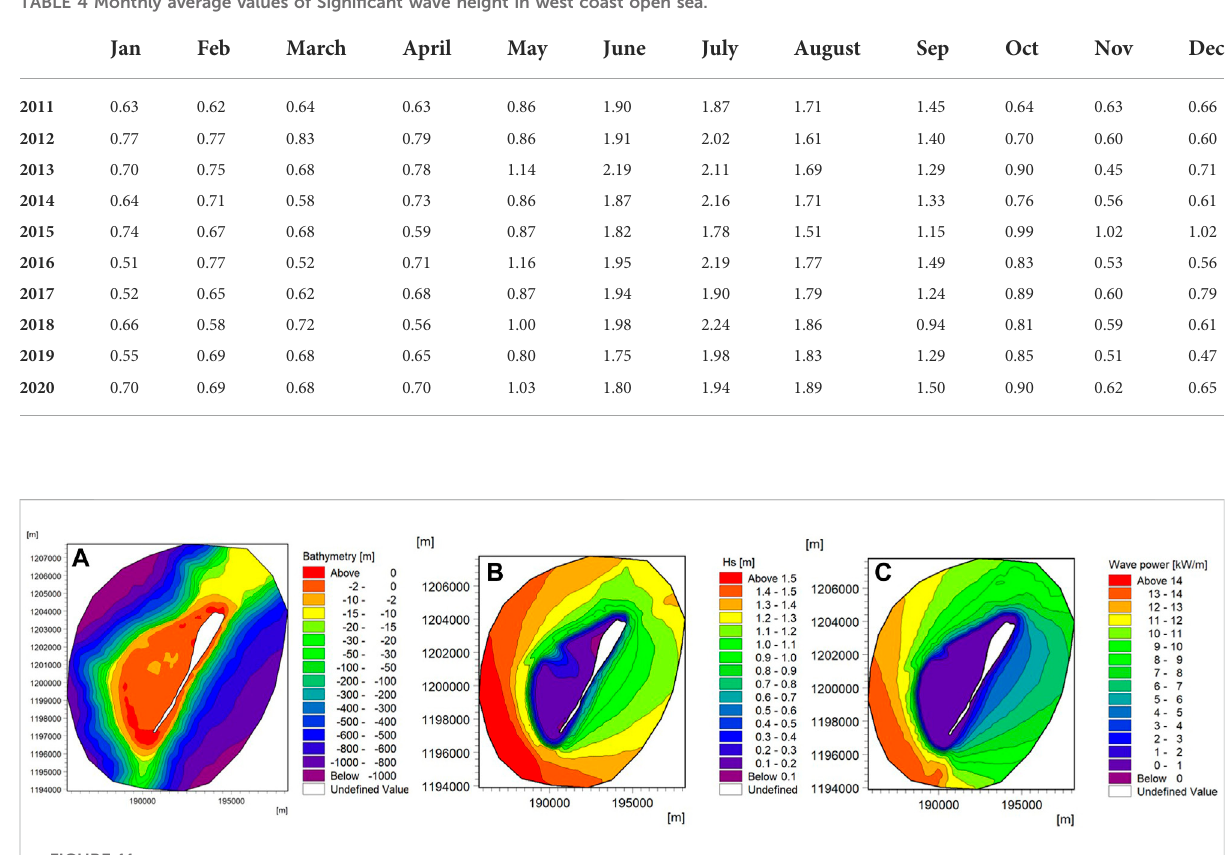
TABLE 4 Monthly average values of Signi fi cant wave height in west coast open